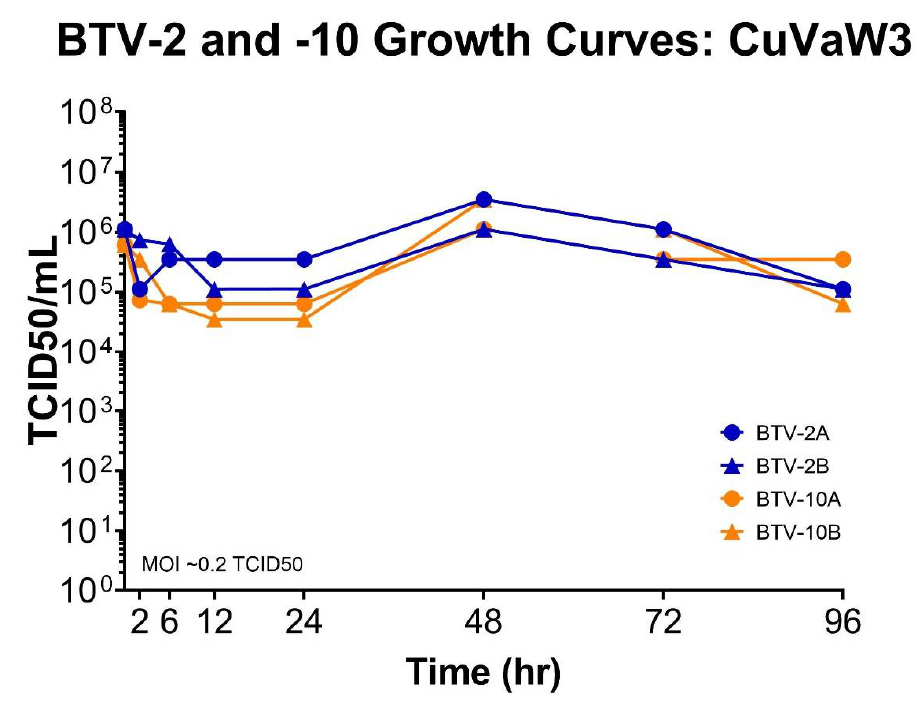
Figure 1. BTV-2 and BTV-10 growth kinetics on CuVaW3 cells. BTV-2 and BTV-10 were used to initiate infections on CuVaW3 cells in duplicate. BTV-2 replicates (BTV-2A or BTV-2B) are shown by blue lines connecting circles or triangles; BTV-10 replicates (BTV-10A or BTV-10B) are shown by orange lines connecting circles or triangles. Cell monolayers were inoculated with an MOI of 0.2 TCID50. Supernatant was collected at 2, 6, 12, 24, 48, 72, and 96 h post infection. TCID50s were performed at each time point to determine the titer.